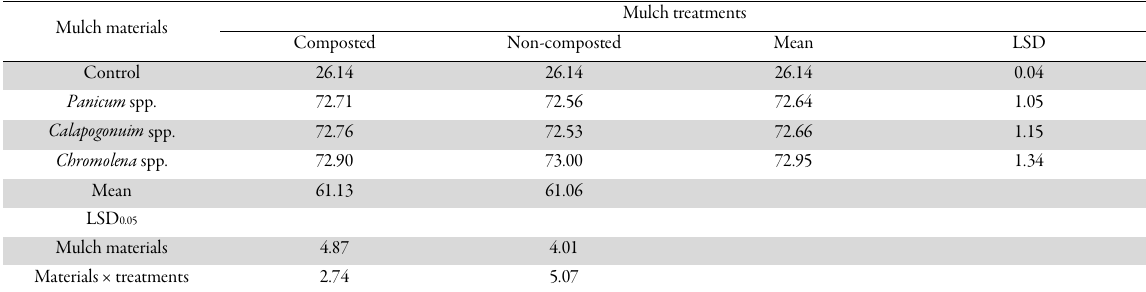
Table 2. Effects of mulch materials and treatment on saturated hydraulic conductivity of soil studied Mulch